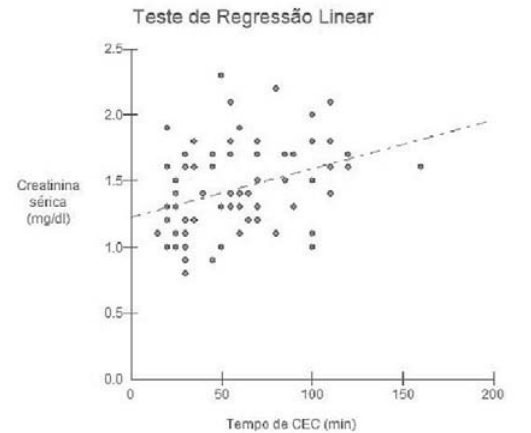
Fig. 2 - Creatinina sérica pós-cirúrgica em relação ao tempo